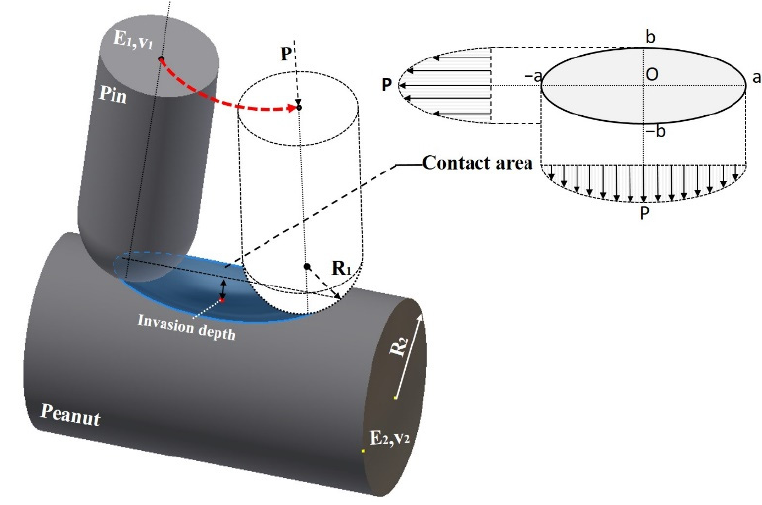
Figure 4. Schematic of the contact and wear areas.